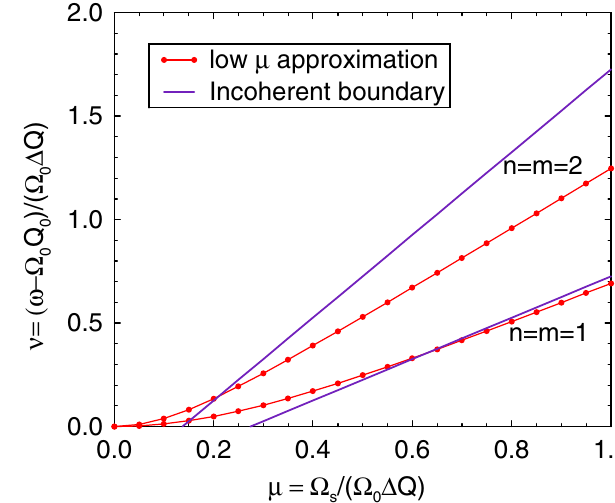
FIG. 15. (Color) Approximate eigenvalues and incoherent boundary of the parabolic